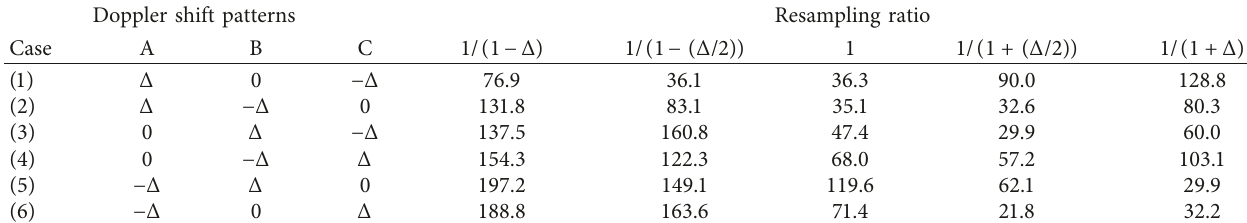
Table 2: EVM results for various Doppler shift patterns and resampling ratios.